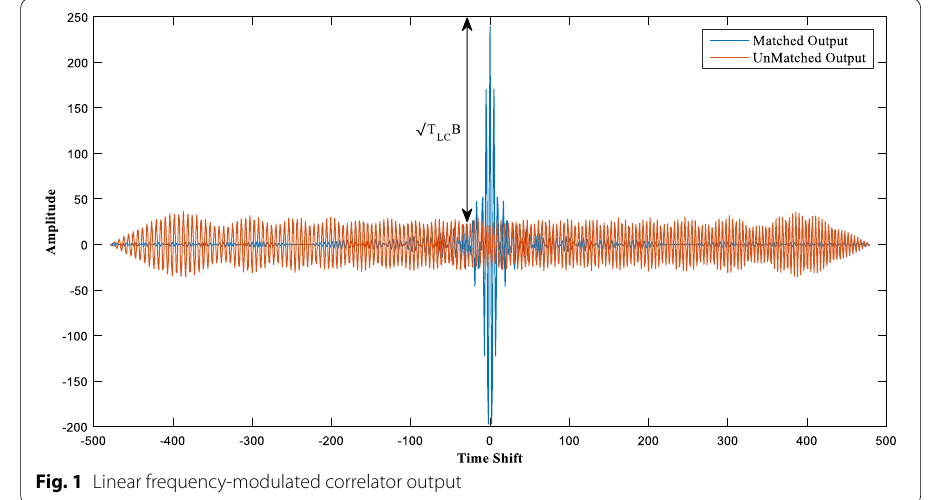
Fig. 1 Linear frequency-modulated correlator output